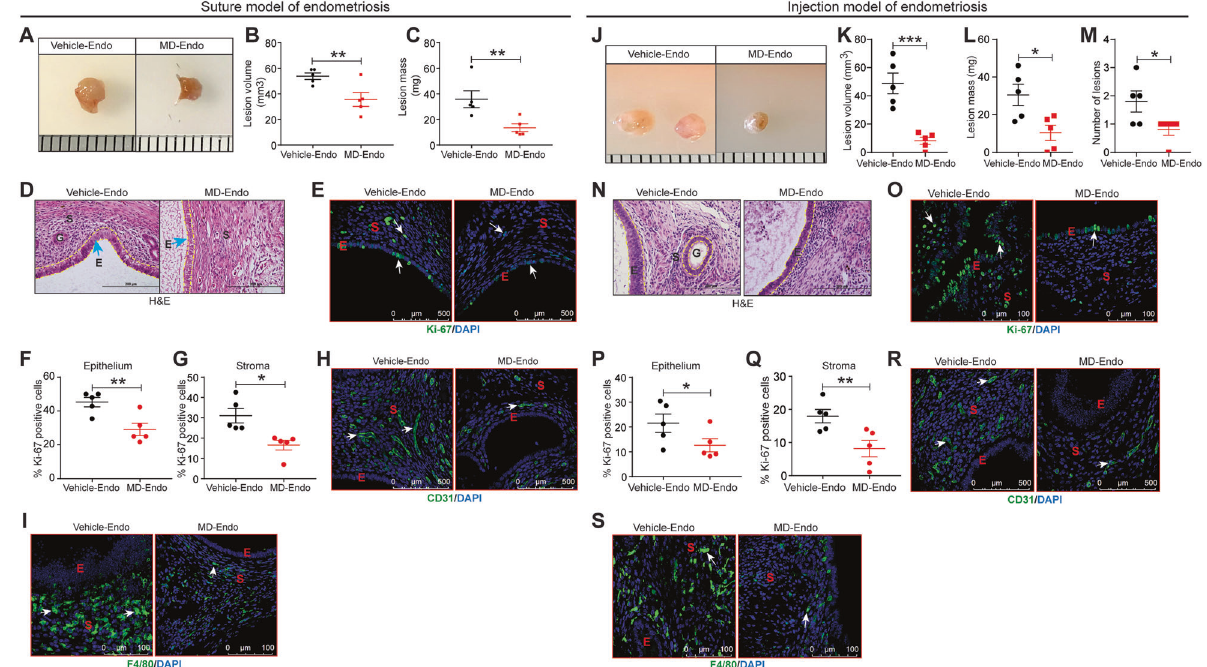
Fig. 2 Gut microbiota promotes endometriosis disease progression in mice. A , J Ectopic endometriotic lesion representative images from A suture model J injection model. B , K The endometriotic lesion volumes from B suture model and K injection model. C , L The endometriotic lesion masses from C suture model and L injection model from the indicated groups 21 days postinduction of endometriosis. M Number of lesions per mouse in injection model from the indicated groups 21 days post-induction of endometriosis. D , N Representative images of ectopic lesions from D suture model and N injection model from the indicated treatment groups stained with Hematoxylin & Eosin (H&E). E , O Representative images of ectopic lesions from E suture model and O injection model from the indicated treatment groups stained with anti-Ki-67 antibody. F , P Percentages of Ki-67-positive cells in endometriotic lesion epithelium, F suture model and P injection model; G , Q stroma, G suture model and Q injection model. Representative images of ectopic lesions stained with H , R anti-CD31 in H suture model and R injection model; I , S anti-F4/80 I suture model and S injection model from the indicated treatment groups. White arrows indicate positive cells. Data are presented as mean ± SE ( n = 5), * P < 0.05, ** P < 0.01 and *** P <